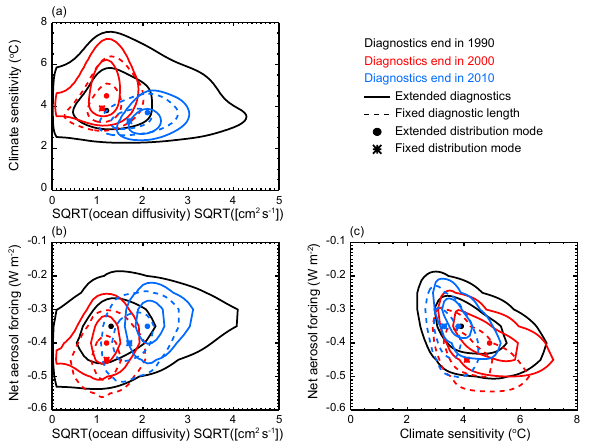
Figure 10. Two-dimensional joint probability distribution func- tions for each pair of parameters: (a) ECS– (c) F aer –CS. Distributions with diagnostics ending in 1990 (black), 2000 (red), and 2010 (blue) are shown. Solid contours indicate an extension of the diagnostic and dashed contours indicate that the lengths of the diagnostics remain fixed when incorporating more recent data. Contours show the 90% and 50% credible intervals and symbols indicate the distribution